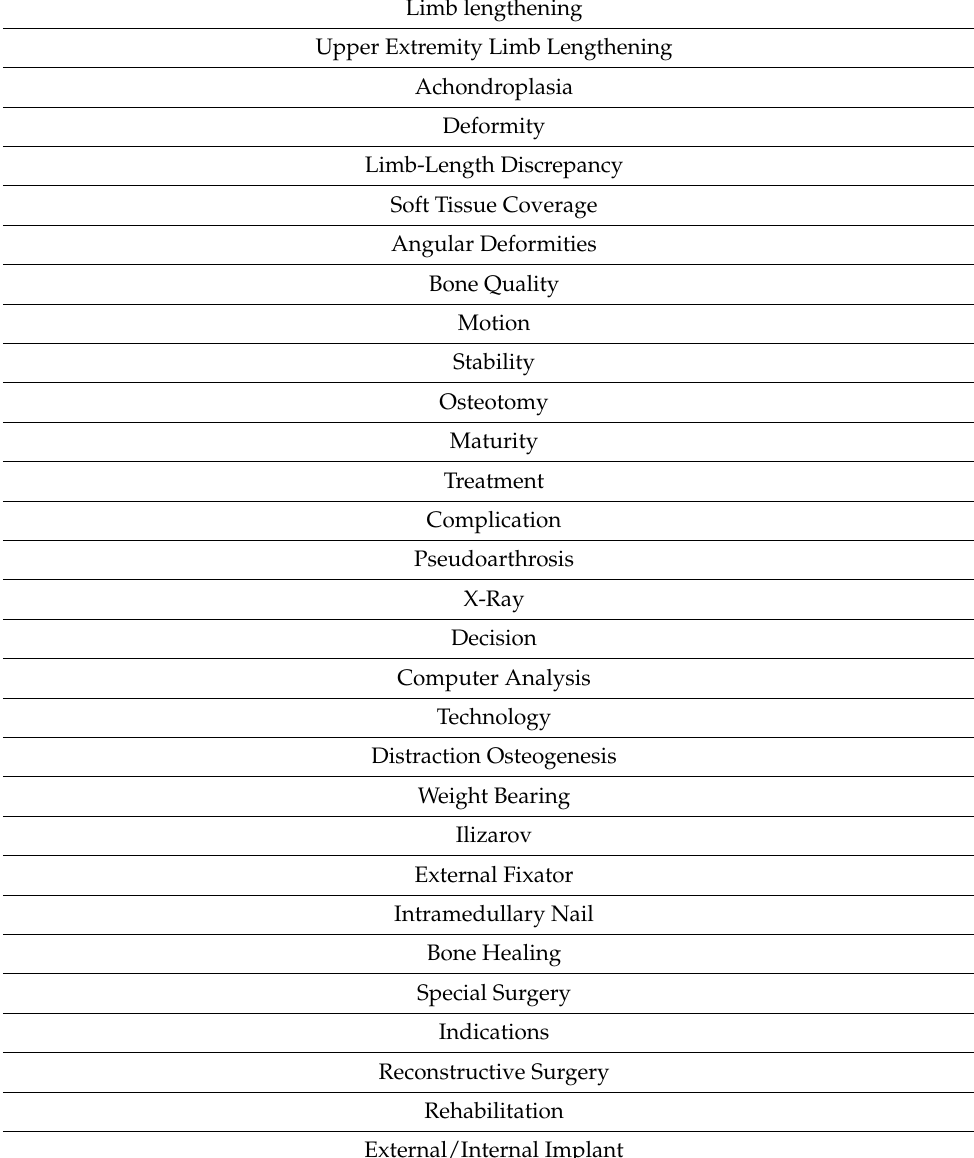
Table 1. Limb Lengthening Content Score